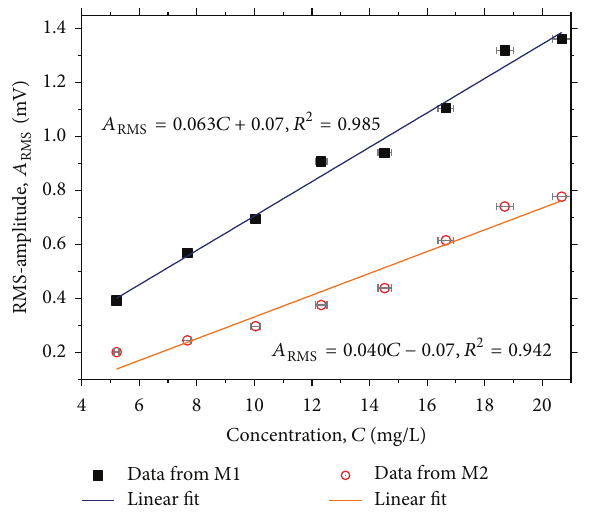
Figure 4: RMS-amplitude analyses of the PLPA-signals detected in the M1 and M2 PZT-microphones as functions of the CV- chromophore concentration (H 2 O based